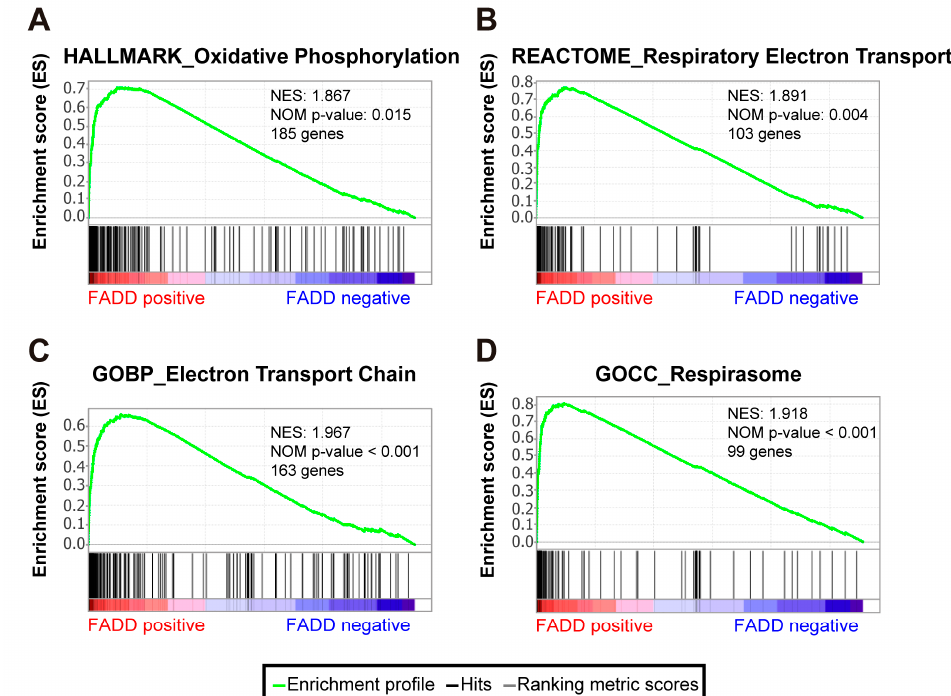
Figure 4. The FADD -positive phenotype showed a significant association with energy metabolism signatures. Gene Set Enrichment Analysis was performed for 264 patients with precursor T-cell neoplasm, based on their FADD expression levels, which defined FADD -negative and FADD -positive phenotypes. These signatures were significantly enriched in the FADD -positive phenotype and selected from the Molecular Signatures Database. Their systematic names are M5936 (Hallmark_Oxidative Phosphorylation) ( A ), M893 (Reactome_Respiratory Electron Transport) ( B ), M13293 (GOBP_Electron Transport Chain) ( C ) and M25889 (GOCC_Respirasome) ( D ). The green curve corresponds to the enrichment score (ES) curve, which is the running sum of the weighted enrichment score obtained with the GSEA software. NES, normalized enrichment score; p , nominal p -value.